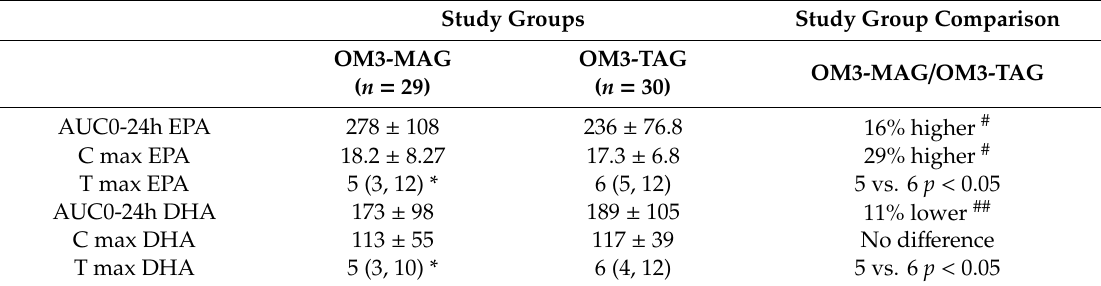
Table 6. Clinical Trial B: EPA and DHA summary statistics, baseline-adjusted, for AUC over 24 h postprandial.